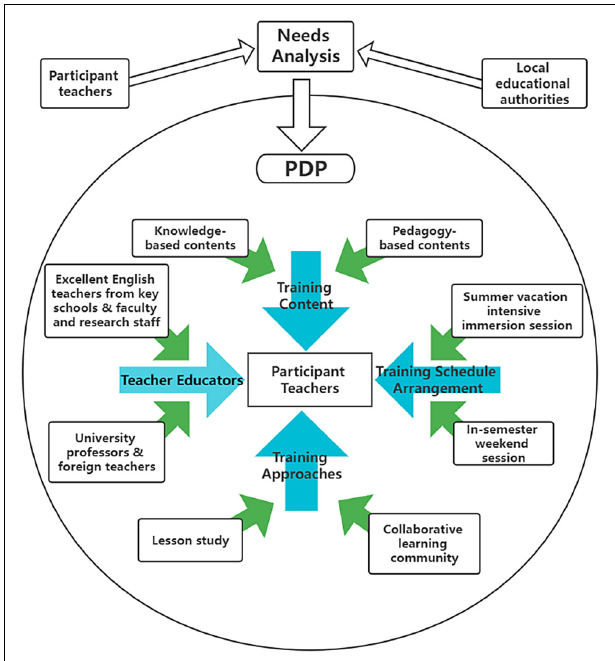
FIGURE 6 | A demand-initiated and tailor-made PDP